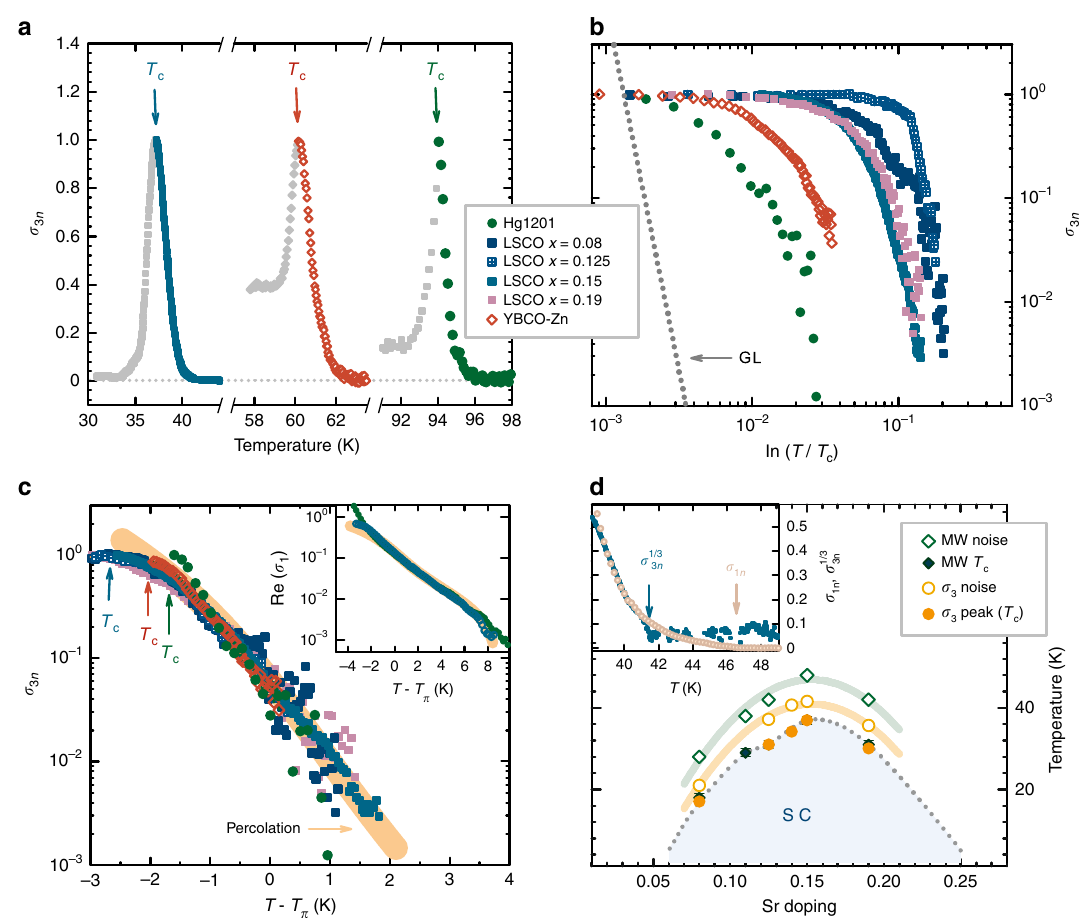
Fig. 1 Temperature dependence of in-plane linear and nonlinear response in the cuprates. a Nonlinear conductivity σ 3 n ( σ 3 normalized to its peak value, which corresponds to the bulk T c indicated by arrows) for three representative samples close to optimal hole doping: Hg1201, YBCO – Zn, and LSCO-0.15 ( x = 0.15). b Nonlinear conductivity vs. Ginzburg – Landau reduced temperature ln( T / T c ), which demonstrates that T c is not the common scale for superconductivity emergence. Dotted line is the GL prediction (see Methods). c σ 3 n shifted by a sample-dependent temperature T π collapses to a single curve. This demonstrates the existence of a universal emergence temperature/energy scale. T c is indicated by arrows (LSCO-0.15, LSCO-0.19, and LSCO- 0.08 have indistinguishable T c values on this scale; T c for LSCO-0.125 is at T − T π = − 4.5 K). Orange line is the prediction of the simple site-percolation model discussed in the text. Inset: linear conductivity of Hg1201 and LSCO-0.15 along with the model prediction. d Phase diagram of LSCO with the characteristic temperatures below which the superconducting response is fi rst resolved in both linear (microwave — MW) and nonlinear conductivity; errors are determined from the root-mean square noise level and are within the symbol size. These temperatures are signi fi cantly different despite the similar signal-to-noise ratio of ~10 3 (at T c ), consistent with the percolation model. The positions of the peaks in σ 3 n and in the real part of σ 1 give consistent T T σ c values. Error bars for c are given by the error of the peak temperature determination (and are within the symbol size for 3 n ). Lines are guides to the eye. The inset demonstrates, for LSCO-0.15, that σ 3 n α σ 1 n 3 until the third-order response is indistinguishable from noise. The two temperatures below which signals are resolved from noise are marked with